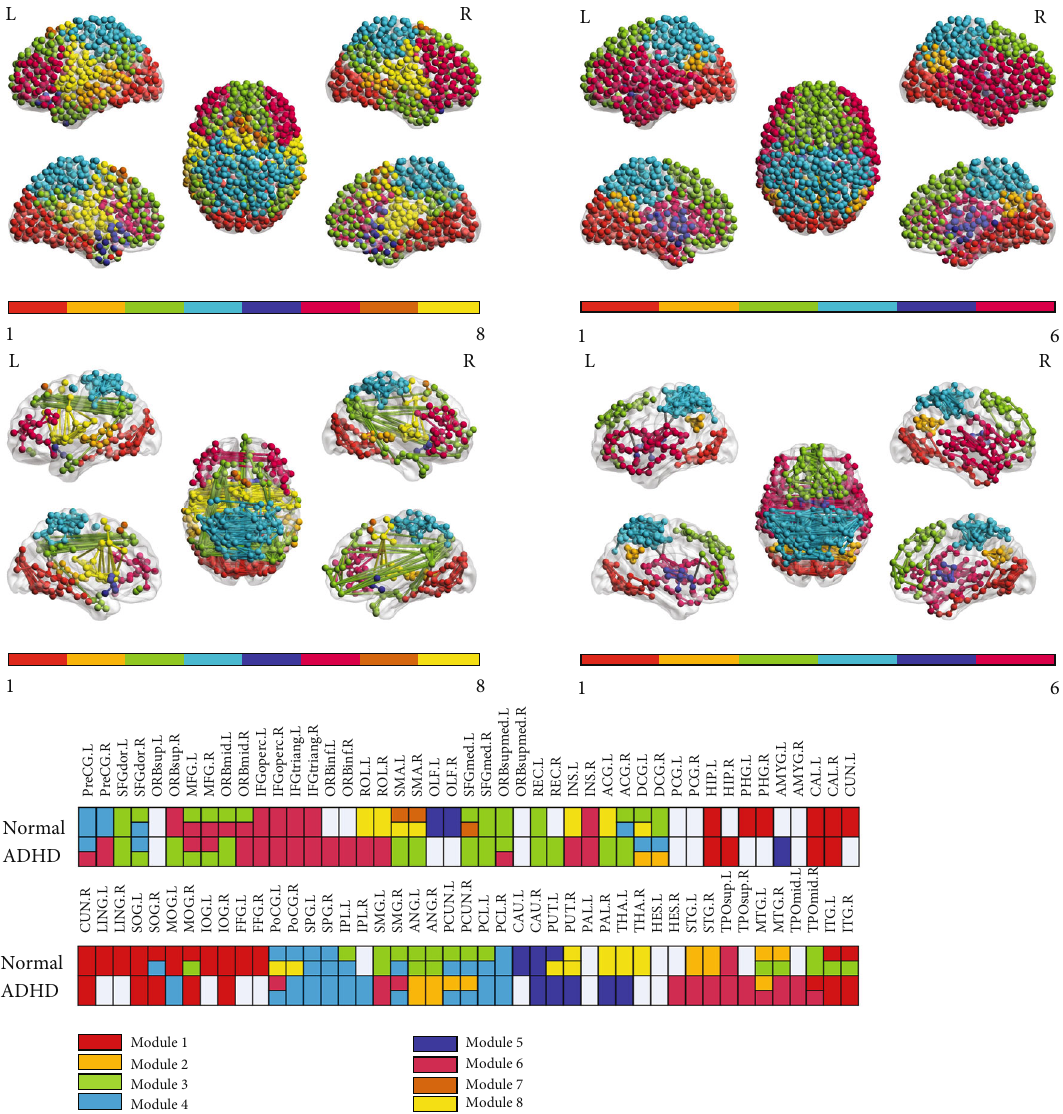
Figure 4: Modular distribution of two groups. The left was the normal group, and the right was the ADHD group; each color represents a